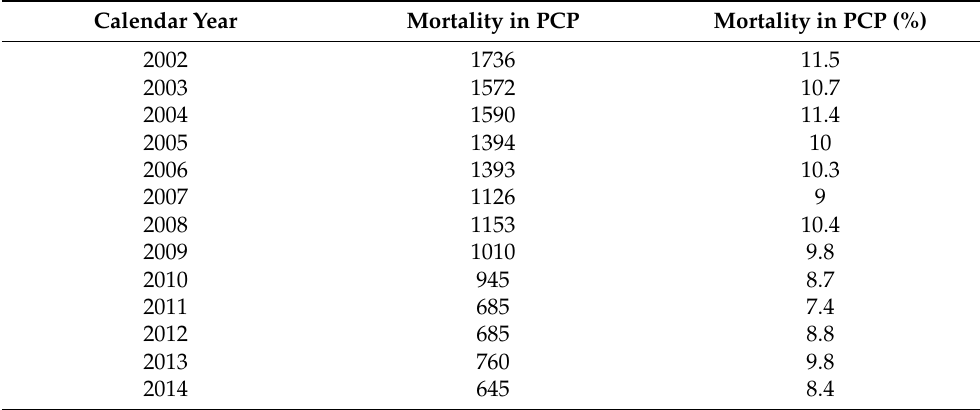
Table 4. Trends of mortality in HIV patients with PCP from